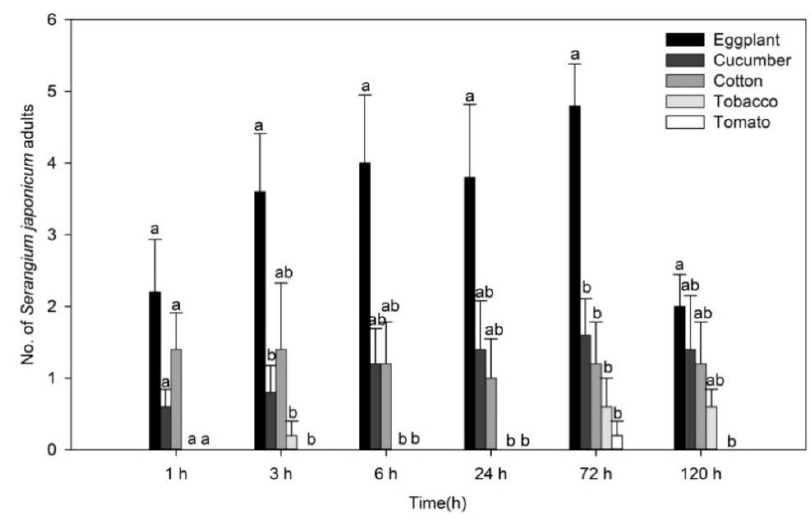
Figure 2. Numbers (mean ± SE) of Serangium japonicum adults on each plant in greenhouse cage experiments. Different lowercase letters mean significant differences among different plant species at the same time at p < 0.05.